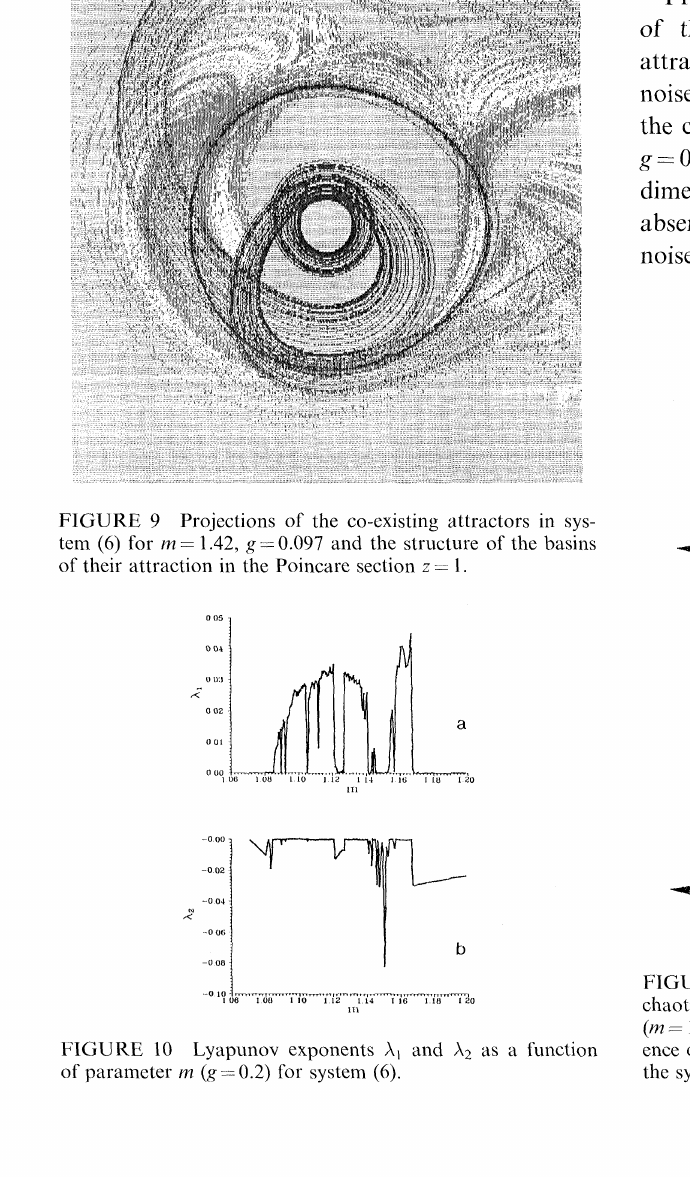
FIGURE 11 Probability distribution density p(x,y) for the chaotic regime in Anishchenko-Astakhov’s oscillator (m= 1.5, g=0.2) in the absence of noise (a) and in the pres- ence of additive noise with intensity d 10 introduced to all the system (6) equations